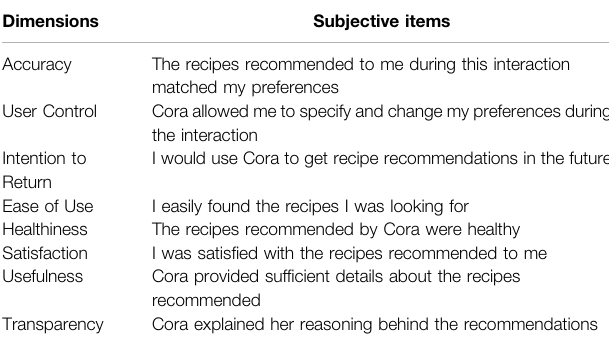
TABLE 2 | Subjective questionnaire adapted from (Pu et al., 2011) to measure users ’ perceived quality of the system.